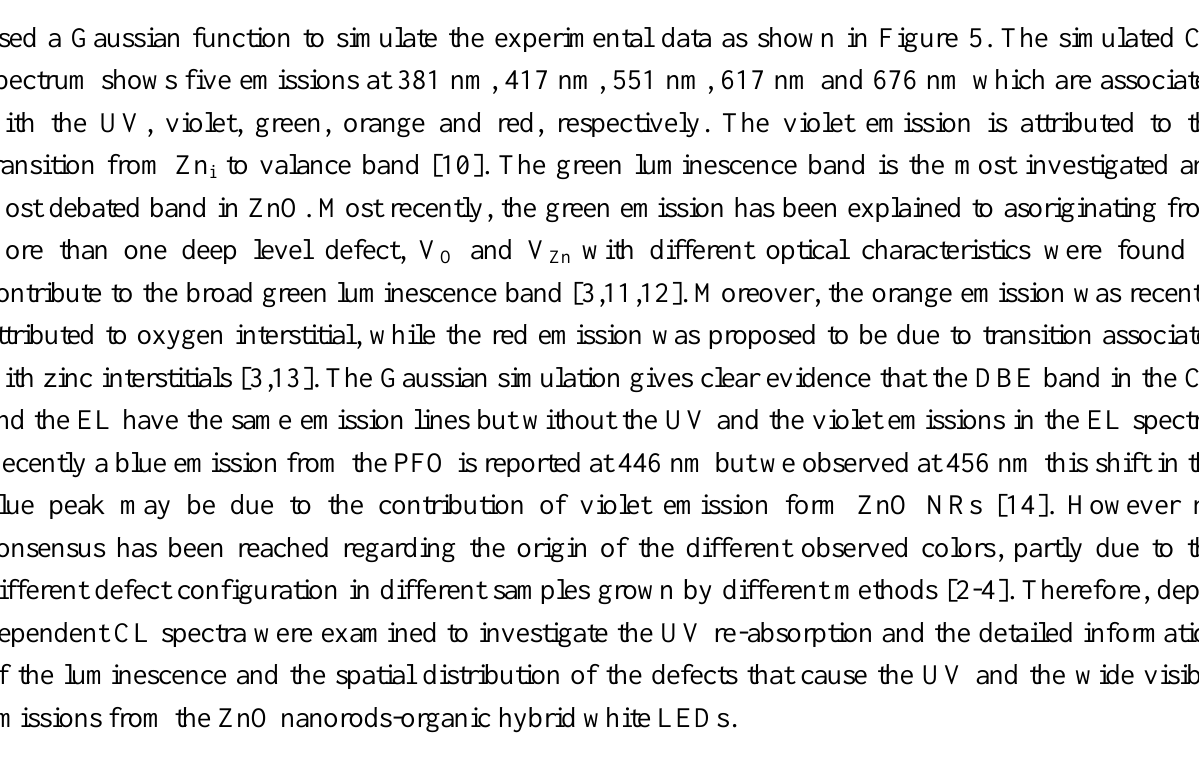
Figure 4. Depth dependent CL spectra of the hybrid LED at room